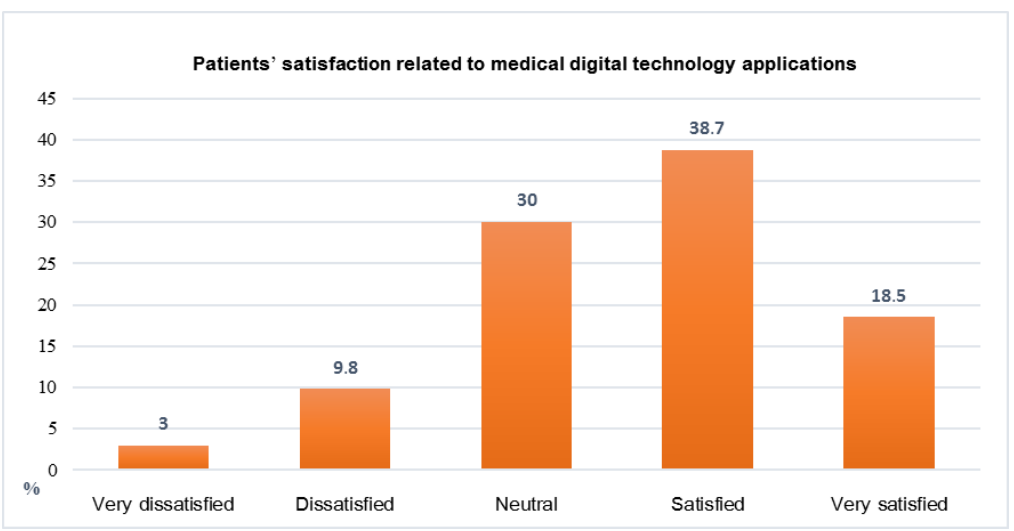
Figure 5. Percentage distribution for patients’ satisfaction related to medical digital technology applications for follow-up during the COVID-19